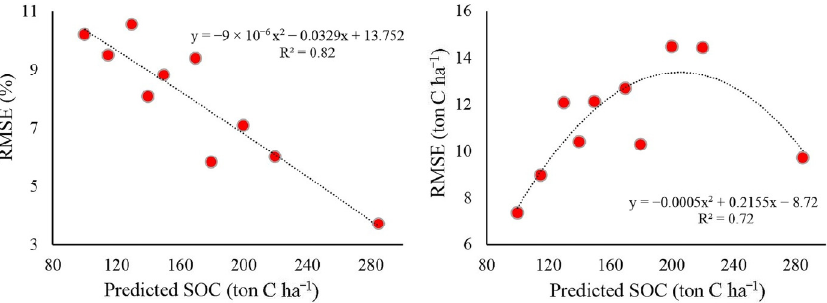
Figure 5. Scatterplots for the 10 bins (based on natural breaks) created to test the regression model of soil organic carbon content (SOC) in the Patagonia region showing the predicted relative RMSE (%) and the predicted absolute RMSE (ton C ha − 1 ).